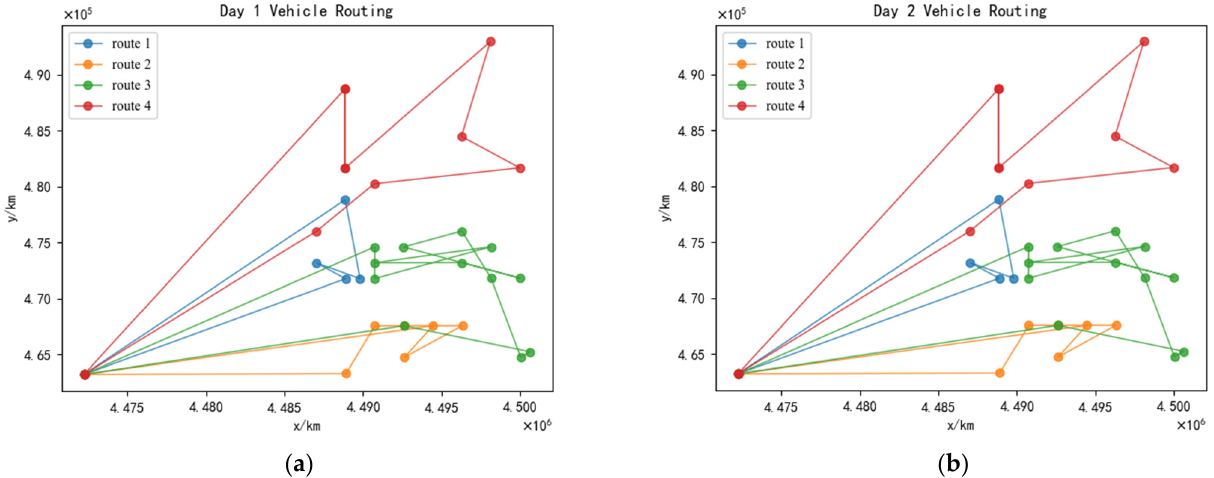
Figure 10. The optimal recycling schemes without considering the cyclical condition. ( a ) Medical waste recycling vehicle route of the first day. ( b ) Medical waste recycling vehicle route of the second day.